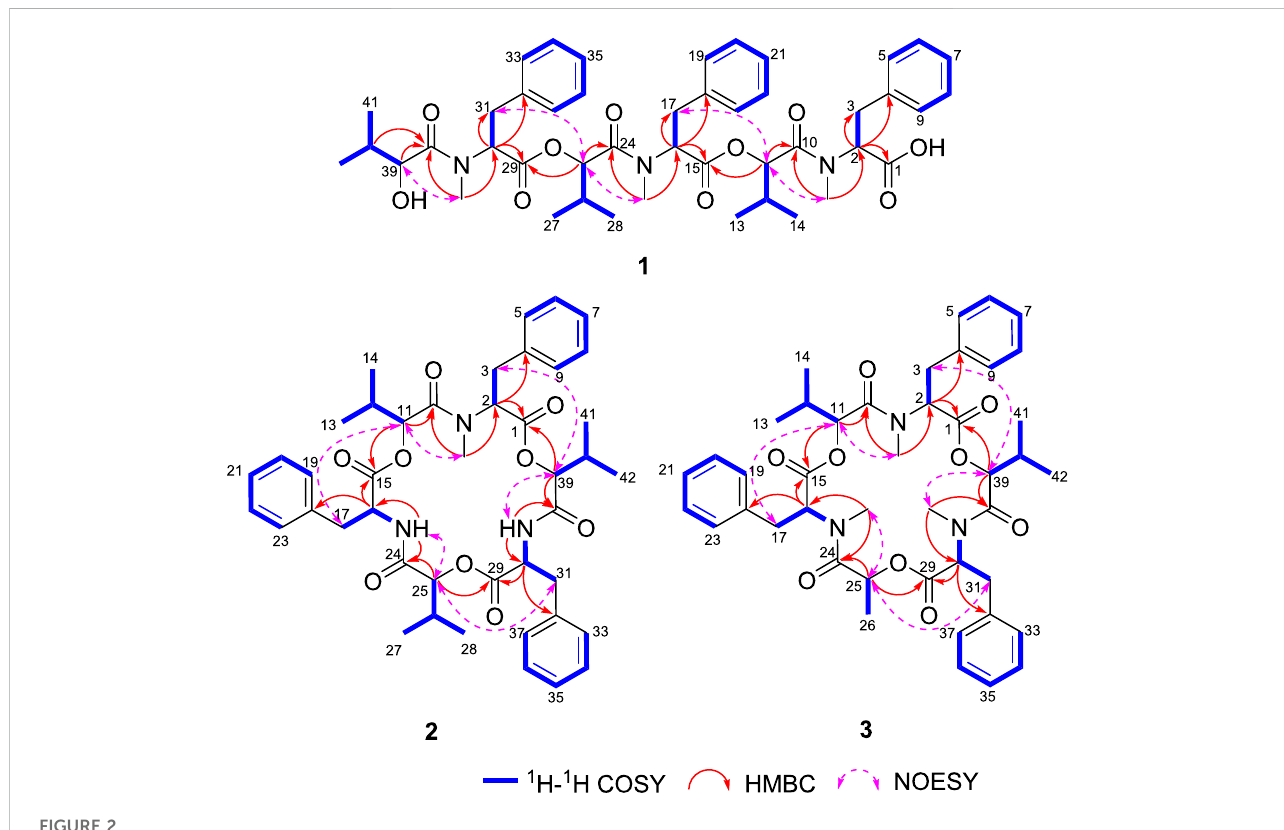
FIGURE 2 1 H – 1 H COSY, HMBC, and NOESY correlations of compounds 1 – 3 .